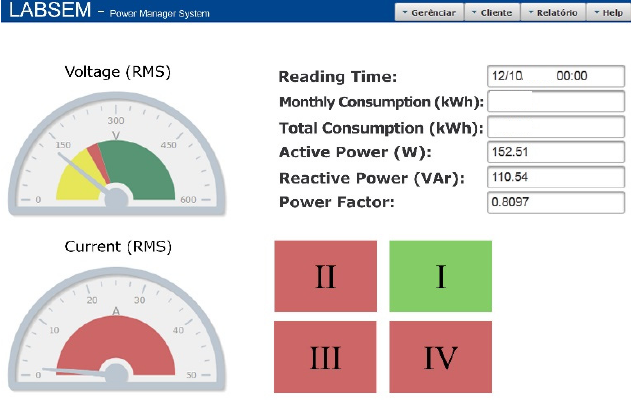
Figure 8. Instantaneous measurements: web interface.